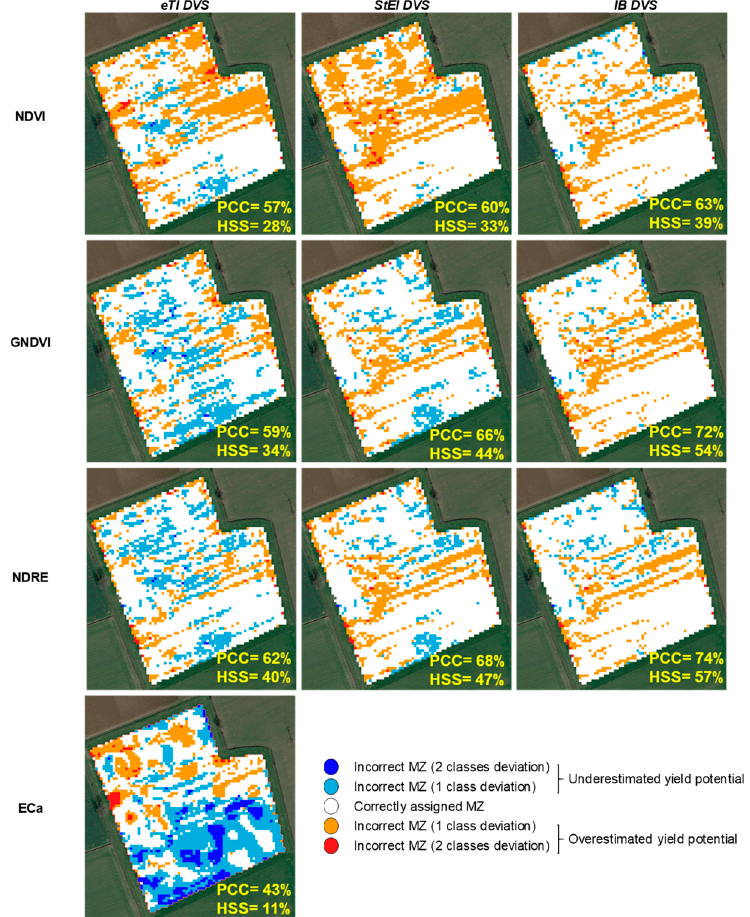
Figure 5. Graphical representation of the di ff erences between the reference yield-based MZs map and the MZs maps based on vegetation indices acquired at three di ff erent development stages (NDVI, GNDVI, and NDRE), and ECa. For each map, the proportion of correct classification (PCC) MZs attribution, and the Heidke skill score (HSS) are reported. Table 2. Critical success index (CSI), BIAS, false alarm ratio (FAR), hit rate (H), probability of false detection (F), and the proportion of correct classification (PCC) were calculated separately for soil and vegetation indices, for MZs and development stage (before planting; early tillering, eTl; stem elongation, StEl; late booting, lB).